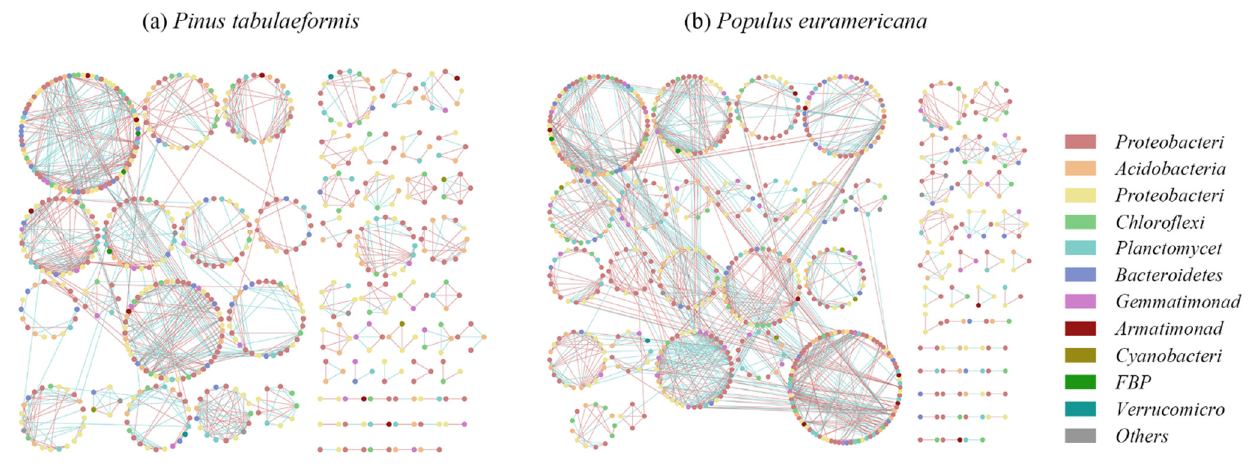
Figure 7. Soil bacterial molecular ecological networks under Pinus tabulaeformis and Populus euramericana.